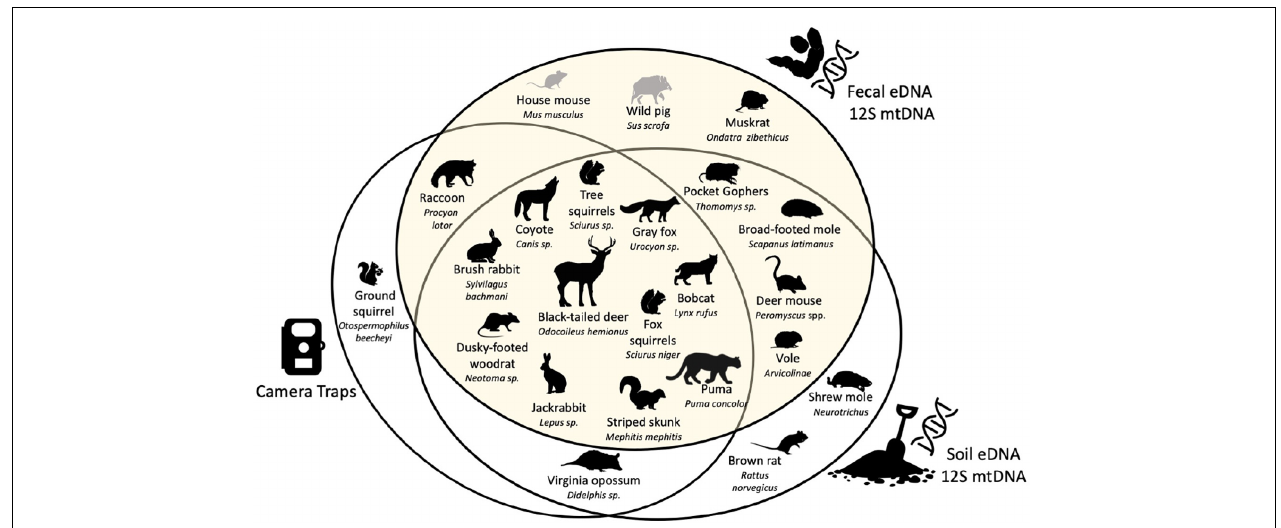
FIGURE 4 | Venn diagram between species recorded by camera traps, and species detected with soil eDNA and fecal eDNA both using the mtDNA 12S metabarcode. Scientific names are given at the maximum rank reached with each metabarcode. Species known to be present in the study area are in black. Species absent from the study area but detected with fecal eDNA are in gray [figure modified from Leempoel et al.